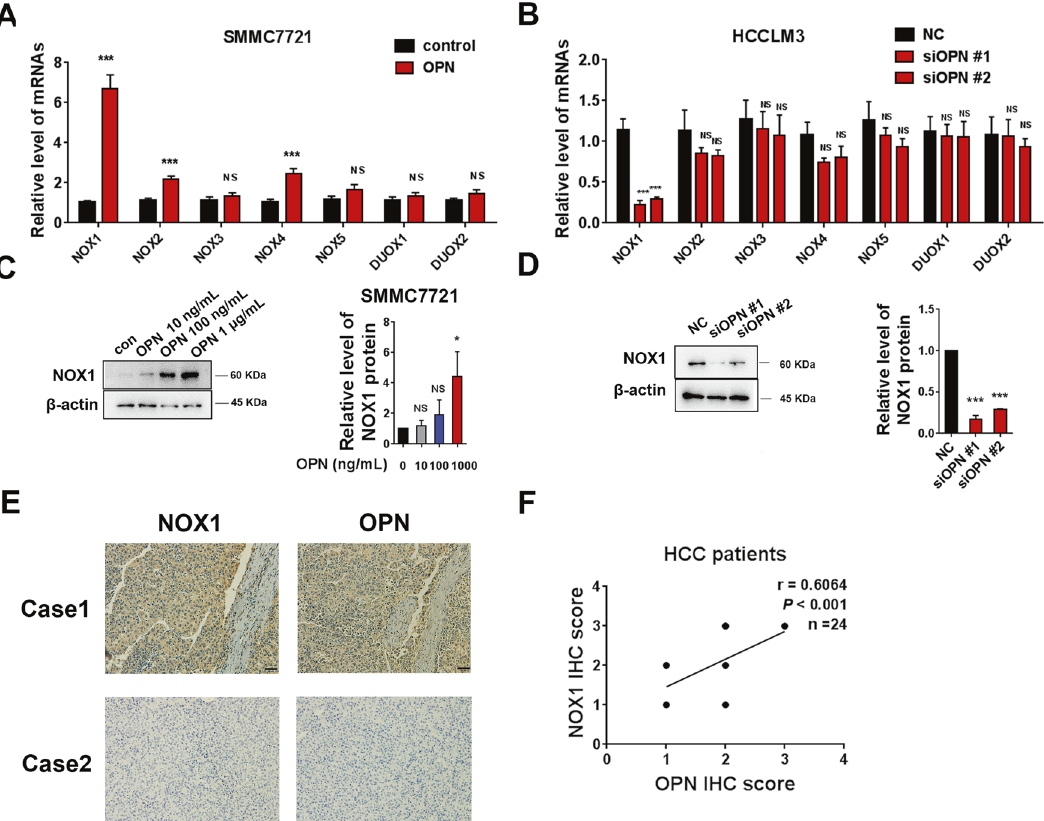
Fig. 2 NOX1 is upregulated by OPN in HCC cells. qRT-PCR was performed to examine the effect of hOPN treatment (1 μ g/mL) and OPN knockdown on the mRNA levels of NOX family ( A , B ). Western blot was performed to examine the effect of hOPN treatment (10